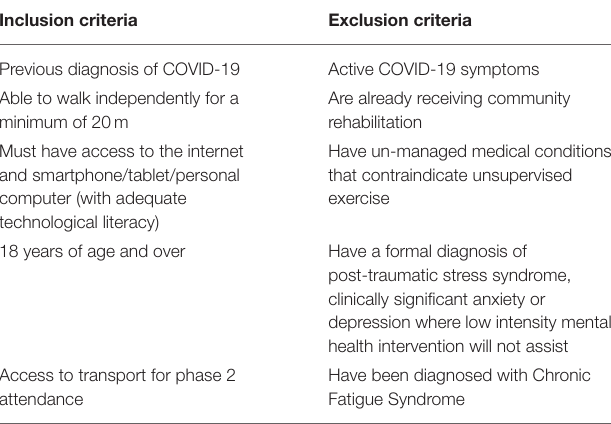
TABLE 1 | Inclusion and exclusion